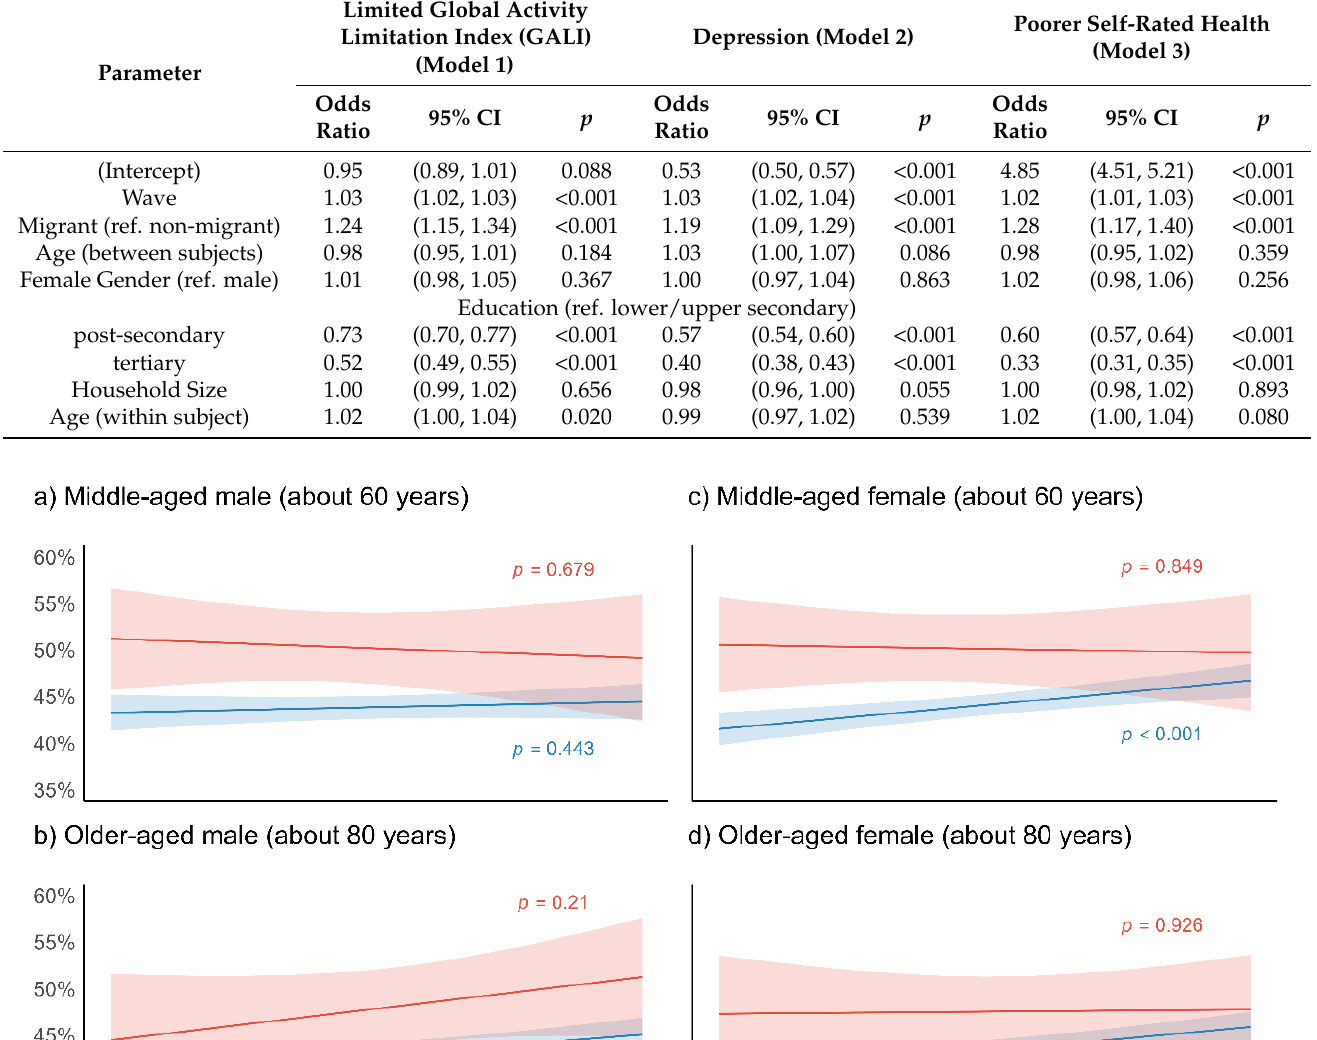
Figure 2. Predicted probabilities of EURO-D (% depressed = four or more symptoms of depression) for migrant back- ground, age and gender (across six waves of SHARE); p -values relate to change over time for migrant and non-migrant elderly.